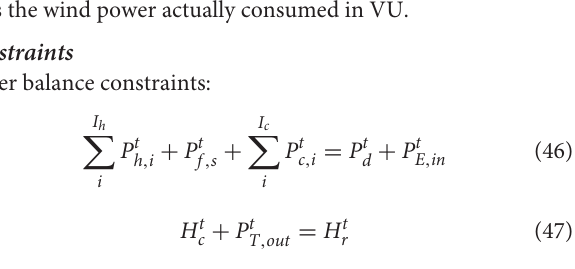
Where, T b represents the number of scheduling periods in